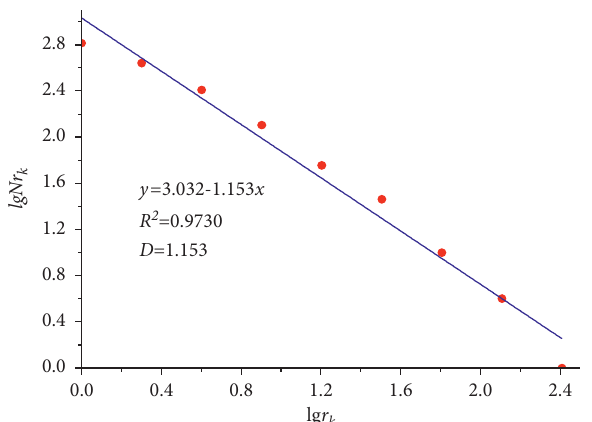
Figure 15: Fitting curve diagram of fractal characteristics of damage area when joint inclination is 30 ° (stress level is 50%).